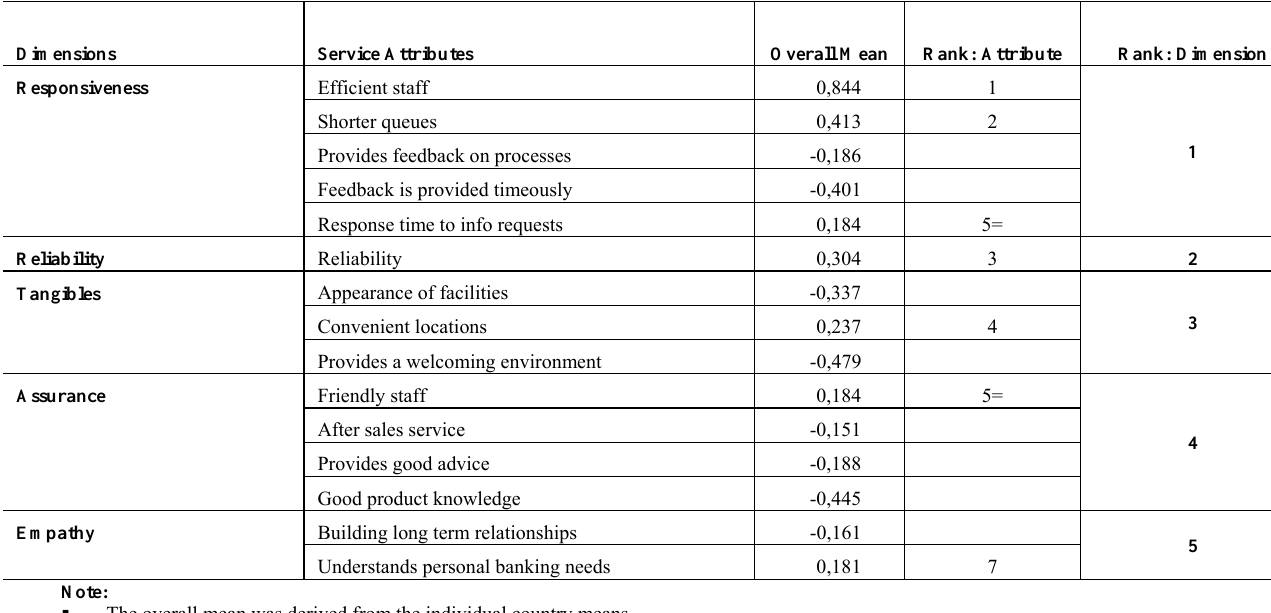
Table 6: Importance ranking of overall means, by service dimensions and attributes